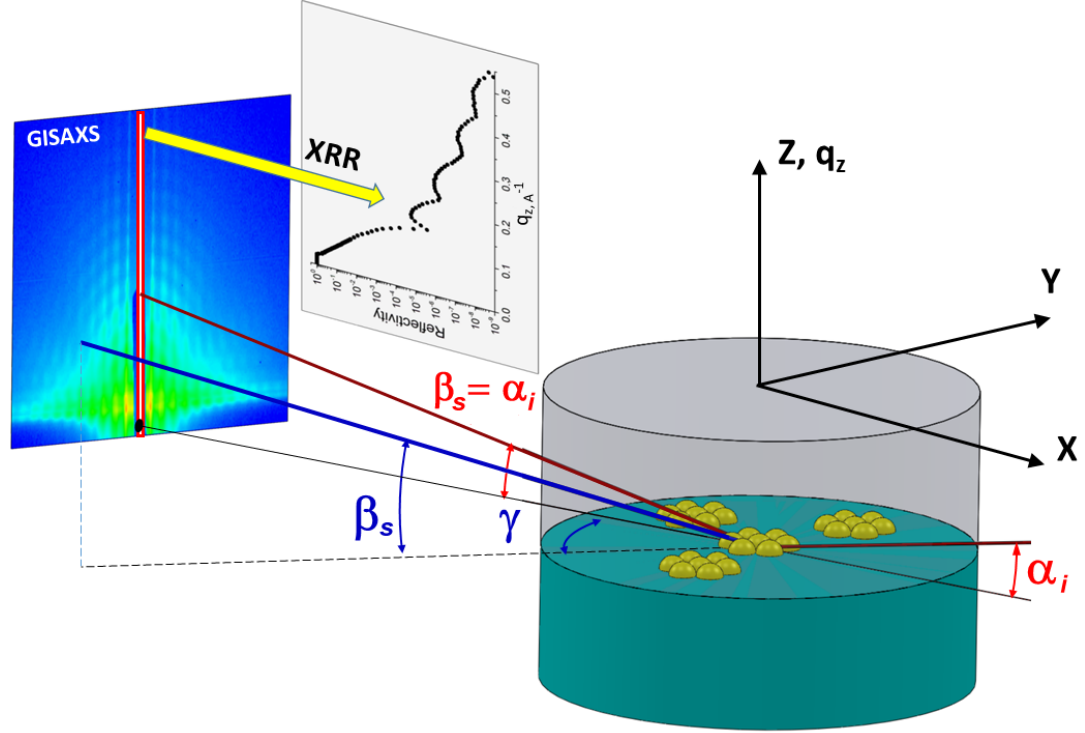
Figure 3. Schematic illustration of the scattering geometry at an interface. Here, α i , β s , and γ are incidence, exit, and in-plane angles, respectively. XRR ( β s = α i ) probes the density profile along the z direction while the off-specular scattering (GISAXS or GIWAXS) elucidates lateral structural organization at the